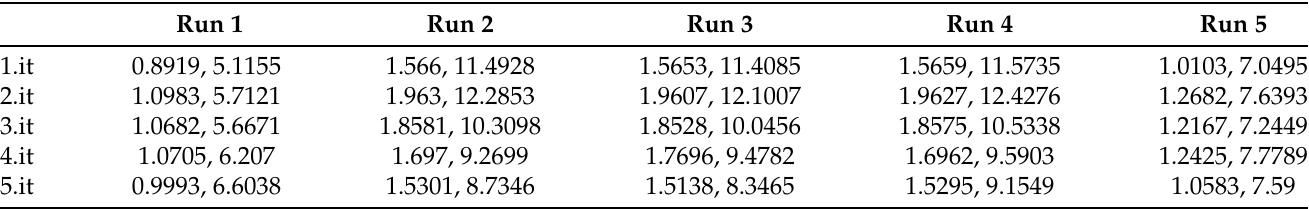
Table 9. The distances (Euclidean, Manhattan) between the testing algorithm and the proposed algorithm for (cid:96) = 17. Run